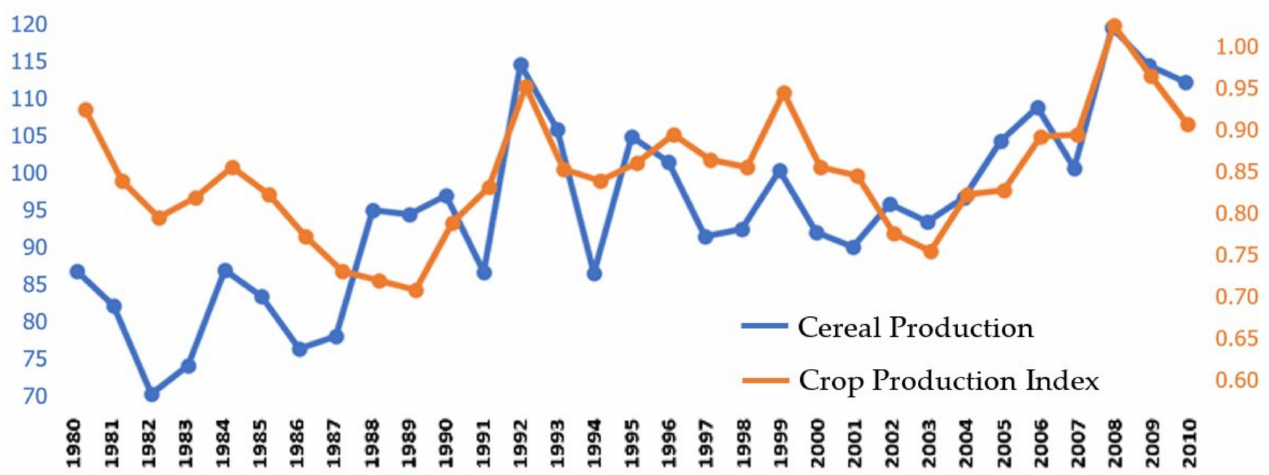
Figure 15. Cereal production (million metric tons) and crop production index in El Salvador for the period 1980–2010 (31 years). Data from